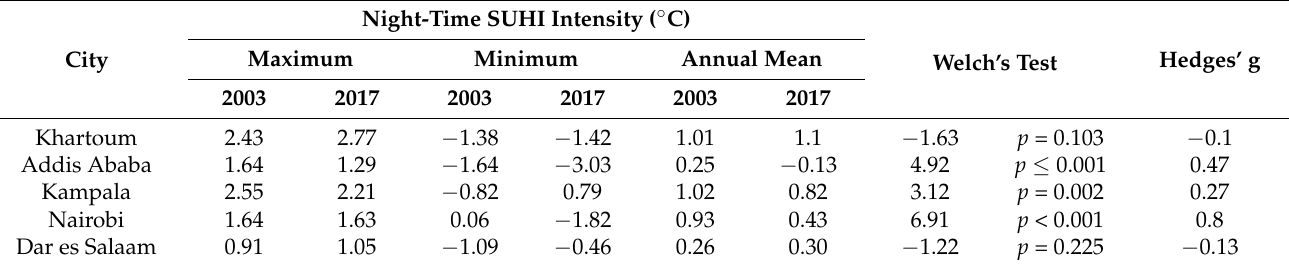
Table 5. Summary of annual night-time SUHI intensity